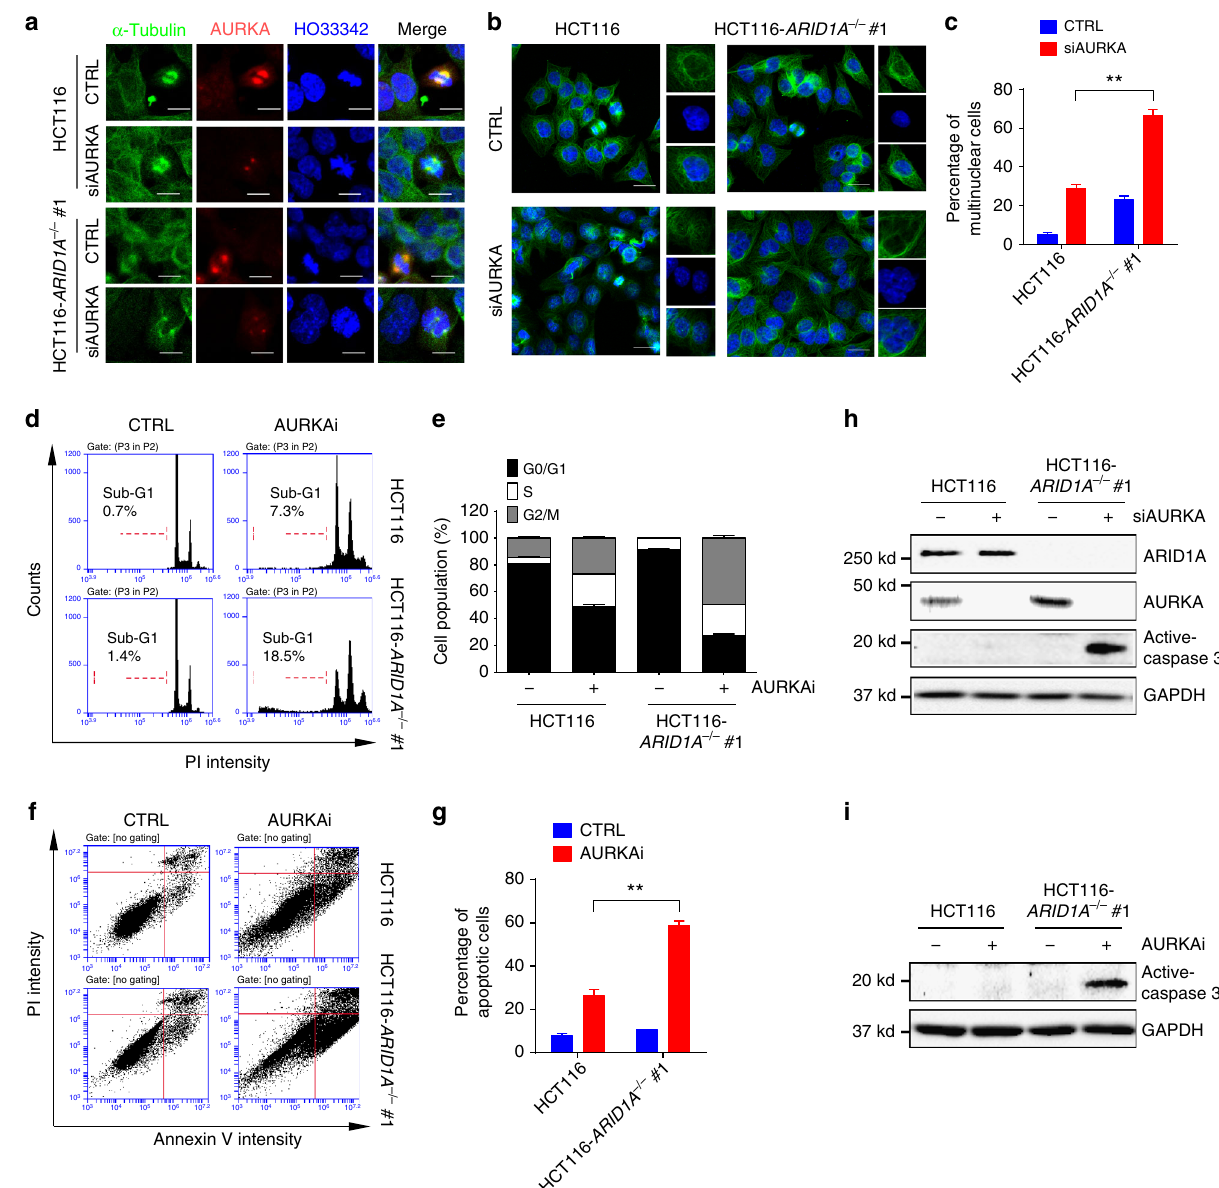
Fig. 4 Induction of multinucleation, G2/M arrest, and apoptosis in ARID1A − / − cells by AURKA inhibition. a Abnormal chromosomal segregation induced by AURKA silencing. ARID1A isogenic HCT116 cells were transfected with AURKA siRNA and analyzed for immuno fl uorescence of AURKA, α -tubulin, and nuclei/chromatin (HO33342). Scale bars, 10 µ m. b Induction of multinucleation in ARID1A − / − cells by AURKA silencing. ARID1A isogenic HCT116 cells were transfected with AURKA siRNA and analyzed for immuno fl uorescence of α -tubulin (green) and nuclei/chromatin (blue). Images in the inlets (red square) are representative cells that were magni fi ed and shown on the right side of each fi gure. Scale bars, 20 µ m. c Percentage of multinuclear cells in ARID1A isogenic HCT116 cells treated with AURKA siRNA. Error bars represent s.d. ** P < 0.01, Student ’ s t test. d Cell cycle analyses of ARID1A isogenic HCT116 cells treated with AURKAi. e Percentage of cell populations in each cell cycle phase. Error bars represent s.d. f , g Preferential induction of apoptosis in ARID1A − / − cells by AURKAi. Cells with or without AURKAi treatment were subjected to FITC – Annexin V apoptosis detection with a fl ow cytometer ( f ) and the percentage of apoptotic cells were quantitated ( g ). Error bars represent s.d. ** P < 0.01, Student ’ s t test. h , i Preferential induction of apoptosis in ARID1A − / − cells by AURKA silencing ( h ) or AURKAi treatment ( i ). Active (cleaved) caspase-3 was used as a marker of apoptosis arrest. The combination of these two effects in ARID1A − / − cells likely caused the increase in multinucleated cells, thereby indu- cing cell apoptosis.